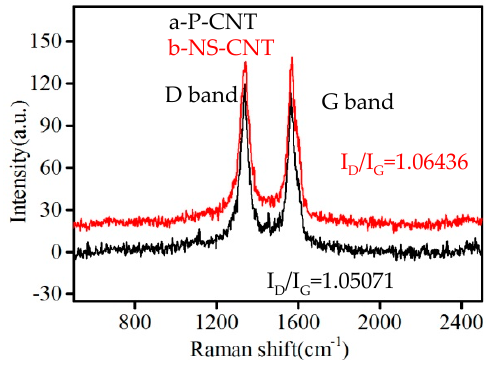
Figure 2. Raman spectra of P–CNTs and NS–CNTs.